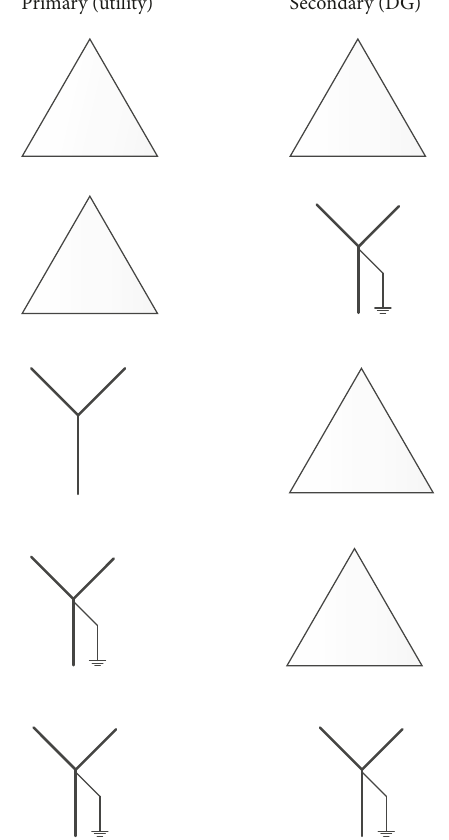
Figure 4: Interconnection transformer connections